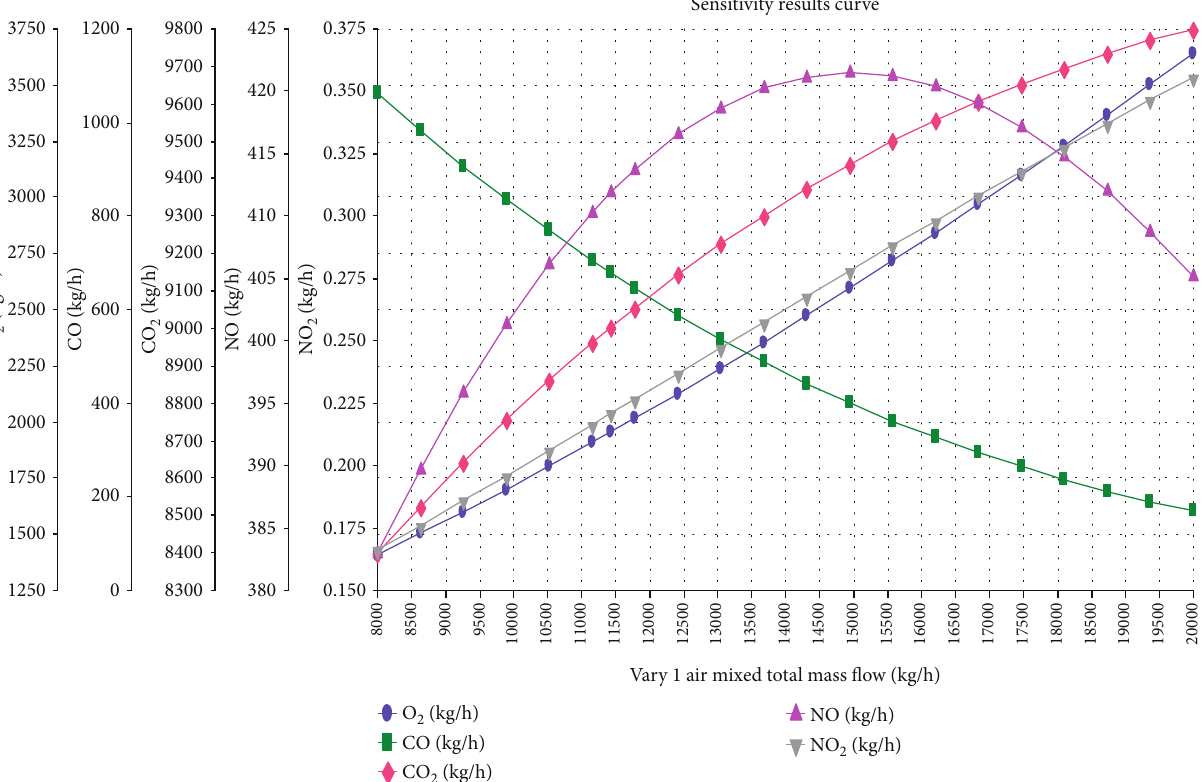
Figure 9: Primary air vs. combustion gas